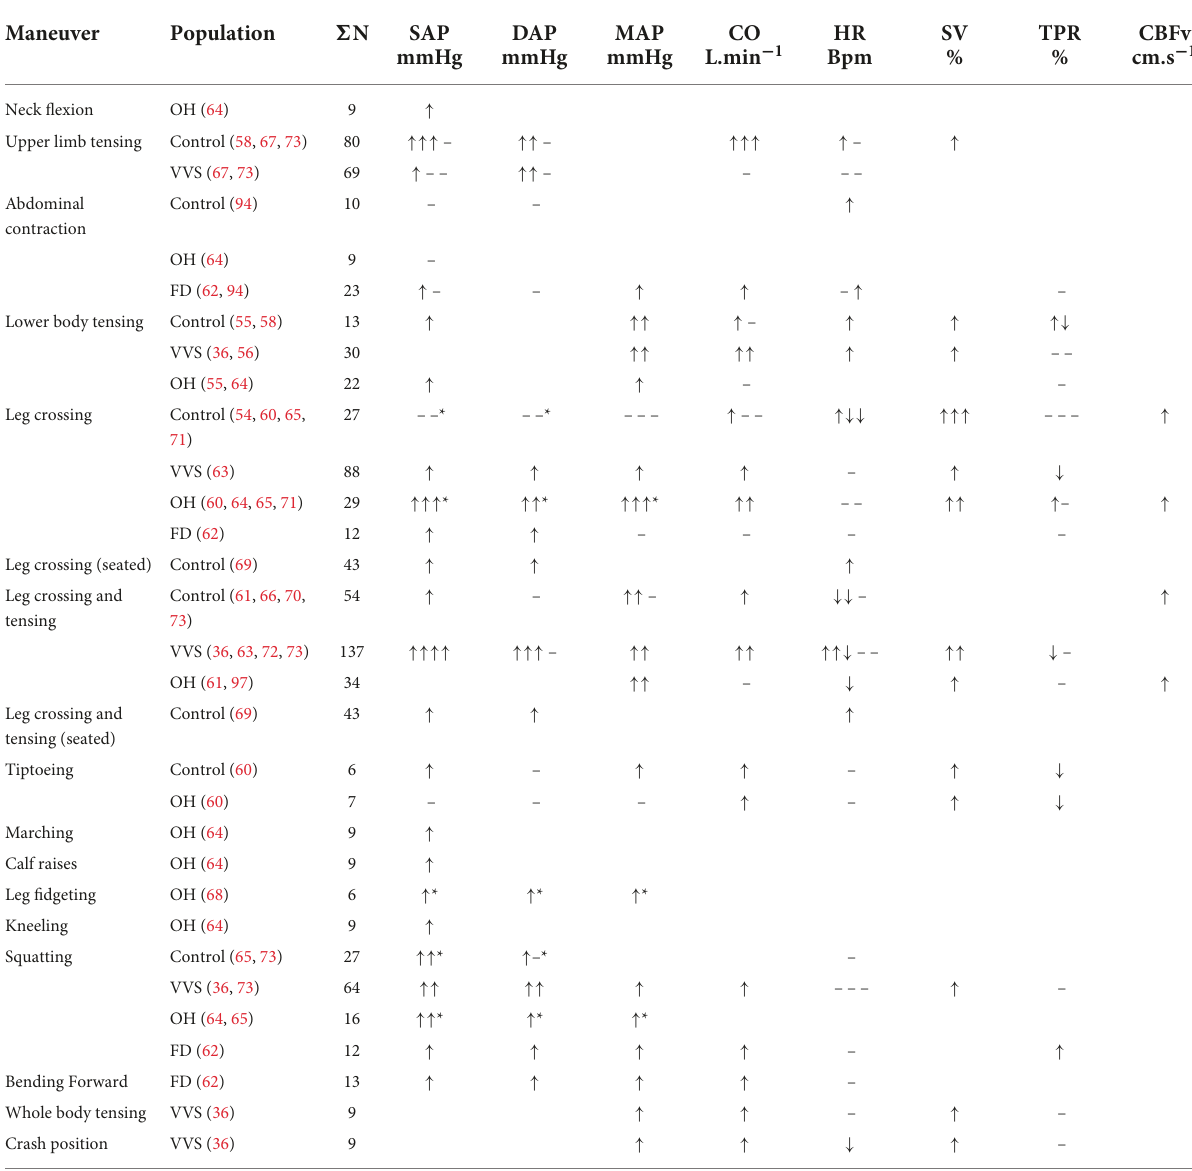
TABLE 2 Cardiovascular responses to counter pressure